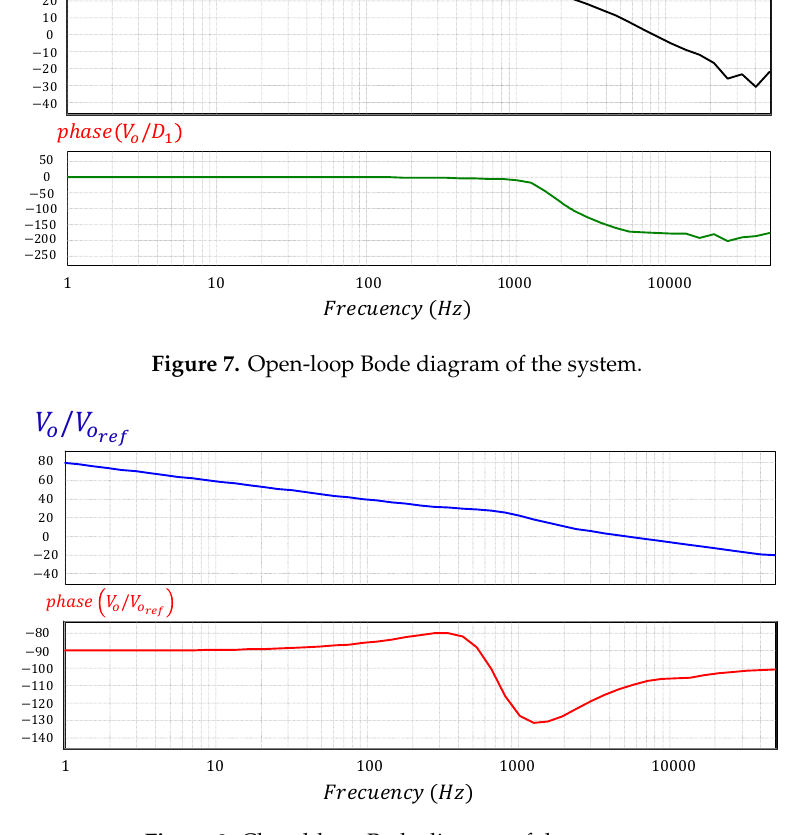
Figure 8. Closed-loop Bode diagram of the system.